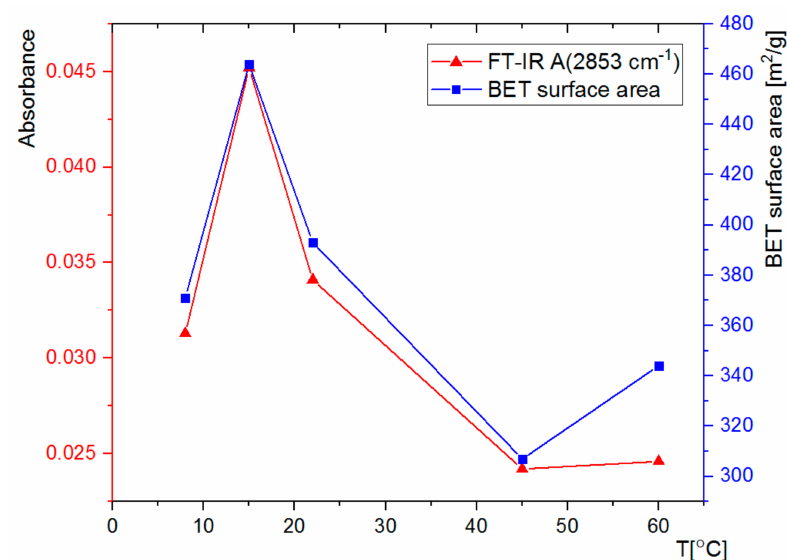
Figure 6. Dependences of absorption of the 2853 cm − 1 band from the FT-IR spectra of the SCMS and BET (based on Brunauer-Emmett-Teller theory) surface area of SCMS-C particles synthesized at various